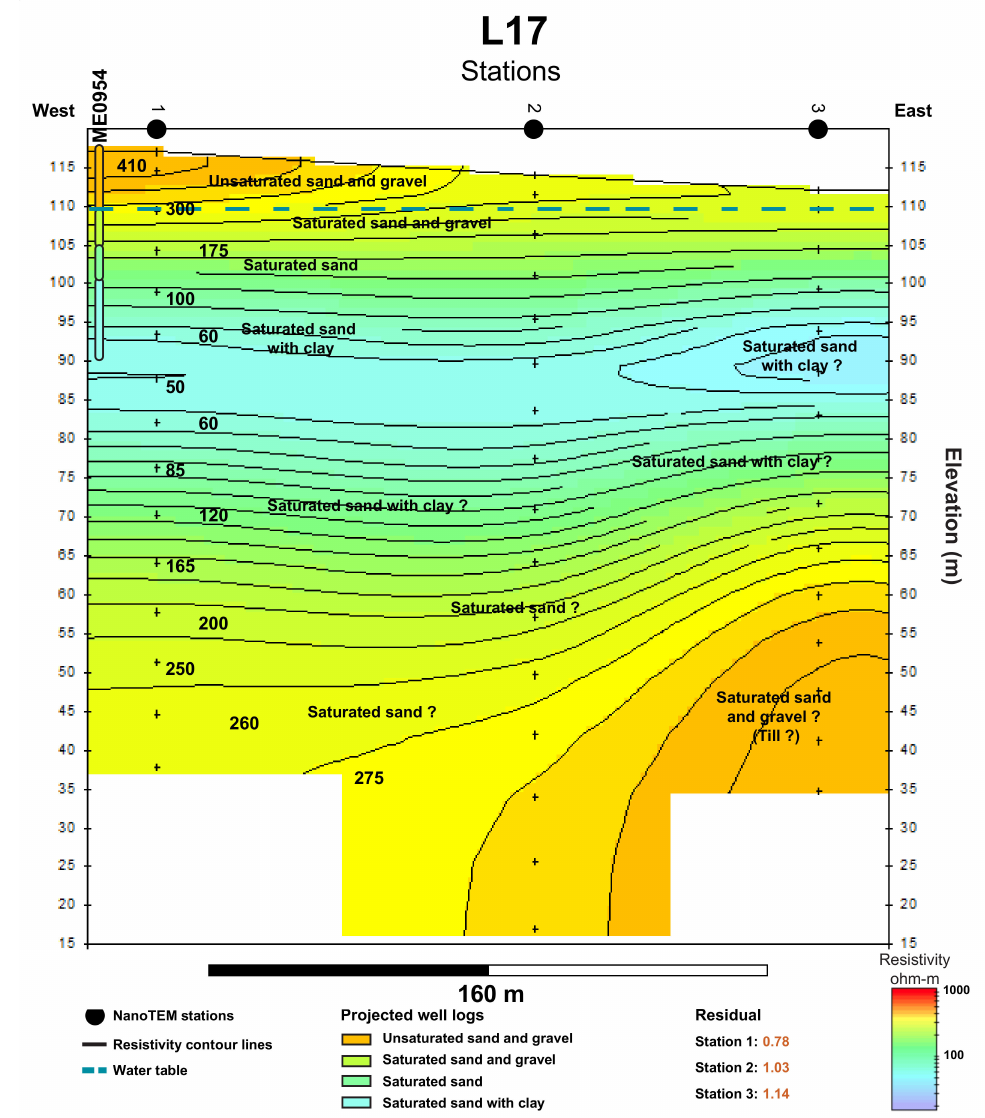
Figure 10. Interpreted 2D Section L17 and borehole ME0954 acquired near Saint-Narcisse, Quebec. The surface deposit elevation is obtained from lidar